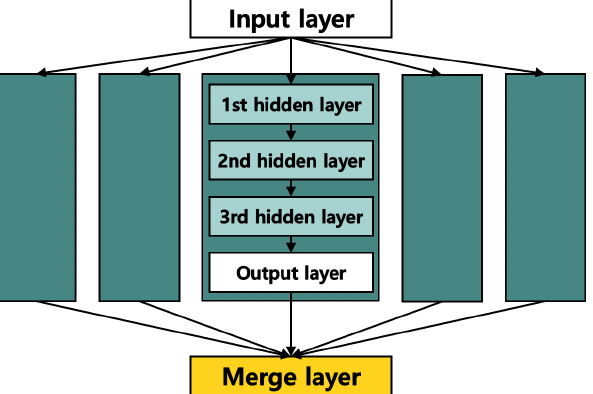
Figure 6. Structure of PAD with 5 CADs.